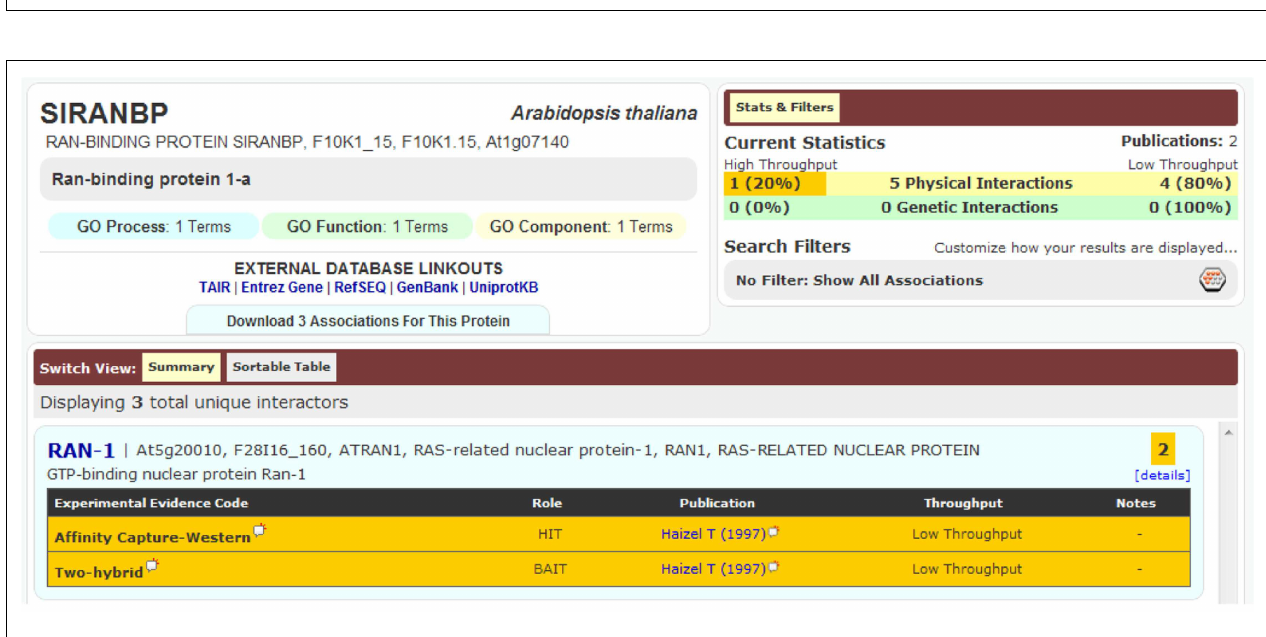
FIGURE 2 | Interaction between SIRANBP (At1g07140) and RAN-1 (At5g20010) was recorded in BioGRID as two separate entries because they were detected using two different methods, despite being from the same